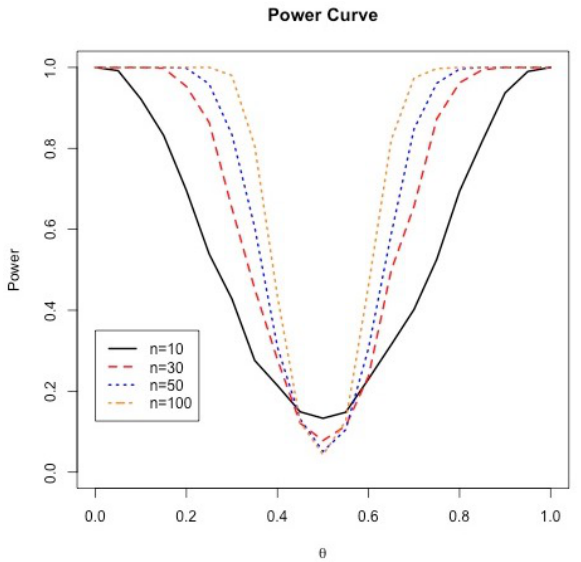
Figure 2. Power curve of the proposed test for various sample sizes n ∈ { 10,30,50,100 }